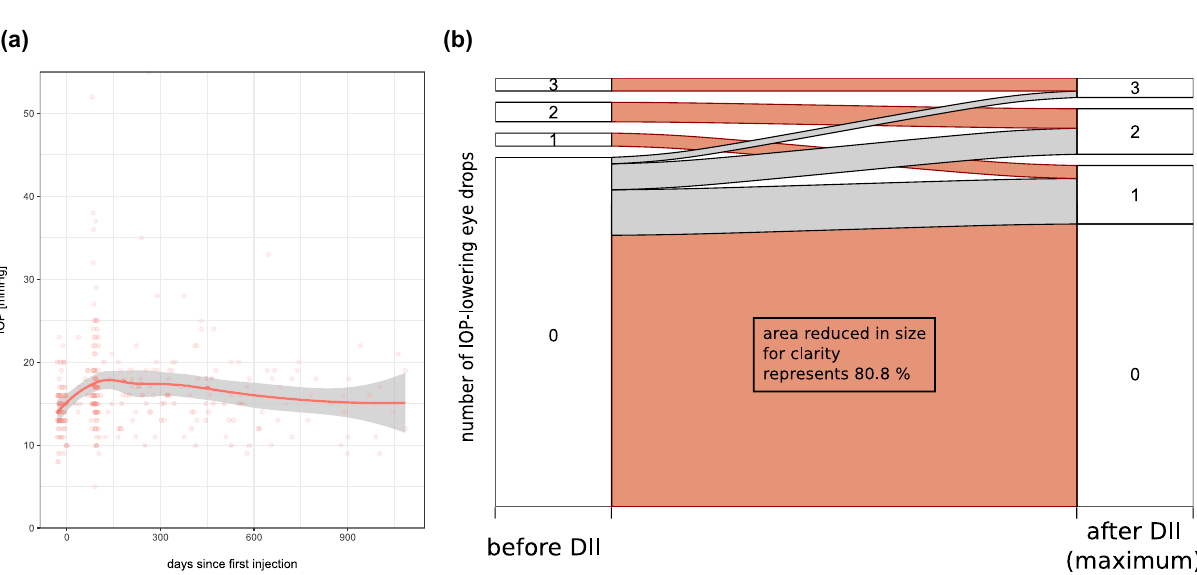
Figure 3. Visual acuity and central retinal thickness. Mean visual acuity stabilizes ( a ) and mean retinal thickness decreases ( b ) under DII treatment over three years. Note the high variability indicated by the individual dots in both plots. The gray area represents the 95% confidence interval.